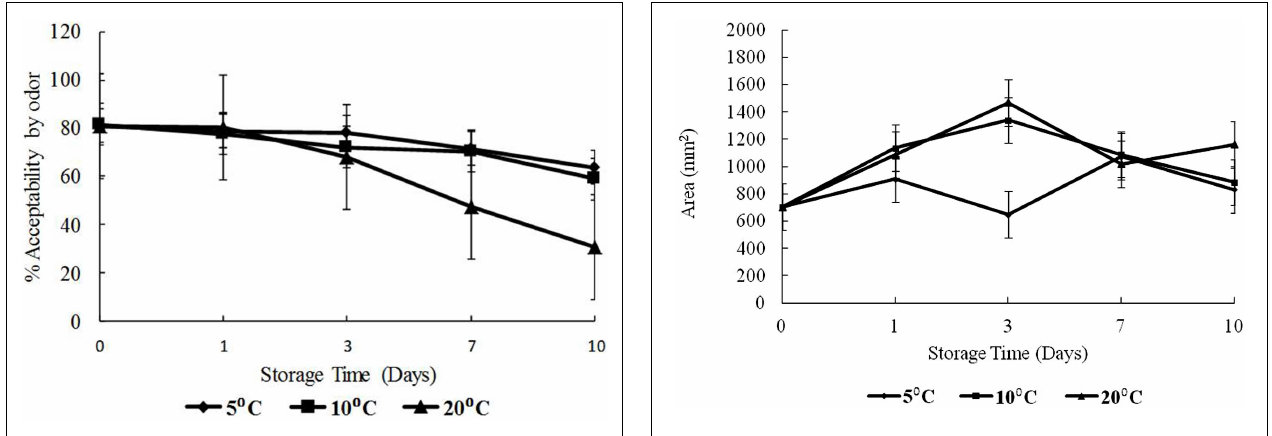
FIGURE 6 | Freshness as determined by odor with time (days) and temperature (5, 10, and 20°C), shown as percent of full scale, 100 = fresh, 0 = not fresh .